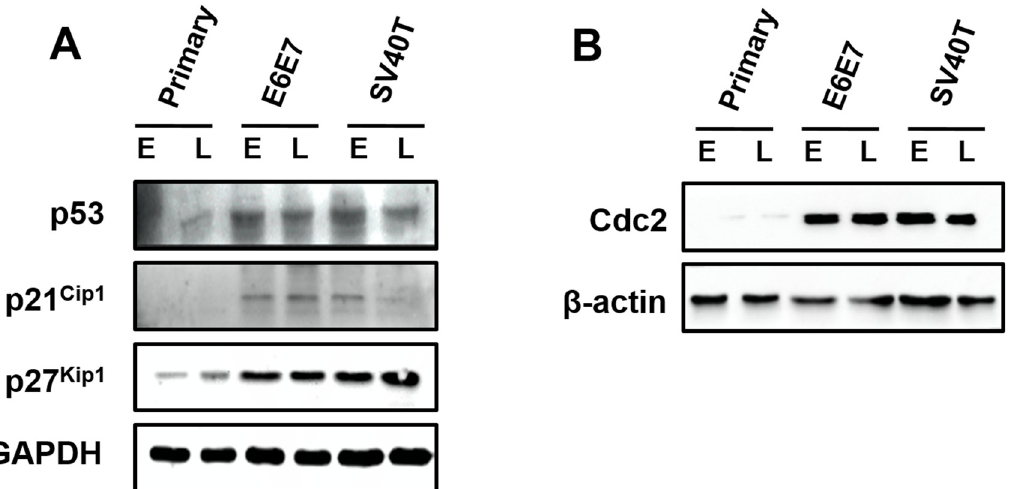
Figure 4. Involvement of p53 signaling pathways in the proliferation of the immortalized BMECs. ( A ) Western blotting analysis of p53, p21Cip1, and p27Kip1 in primary and immortalized BMECs. ( B ) Cdc2 kinase assays of primary and immortalized BMECs. Primary BMECs or BMECs transduced by E6E7 or SV40T were collected at early (E) and late (L) passages of culture. Data are based on triplicate experiments.